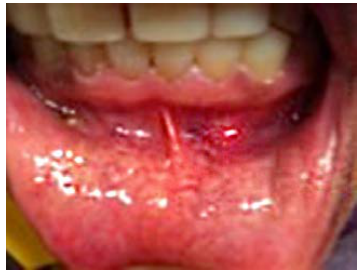
Figure 2. 24 h Pre-op intra-oral mild swelling.